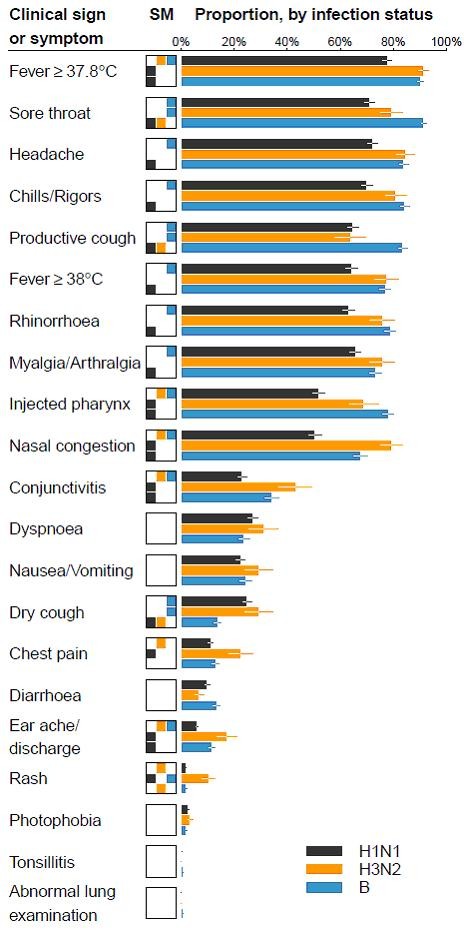
Univariate comparison of clinical signs or symptoms between influenza subtypes. Symptoms or signs are ranked by average frequency over the study period. Empirical frequencies of presentation of each symptom or sign are presented in the right column as bars, with 95% confidence intervals represented by whiskers. Symptoms or signs that have statistically discernible differences in frequencies for pairs of strains at the 5% level are indicated in the significance matrix (SM) column. For instance, for a fever of 37.8 or above, pandemic H1N1 is significantly different from the other two strains, indicated by orange and blue cells in the SM in the row for H1N1-2009, and the grey cell in the rows for H3N2 and influenza B, but the latter have no statistically discernible difference, indicated by the white cells in their rows. With 63 tests, the conservative expected number of false discoveries is 3, assuming no differences at all between strains.